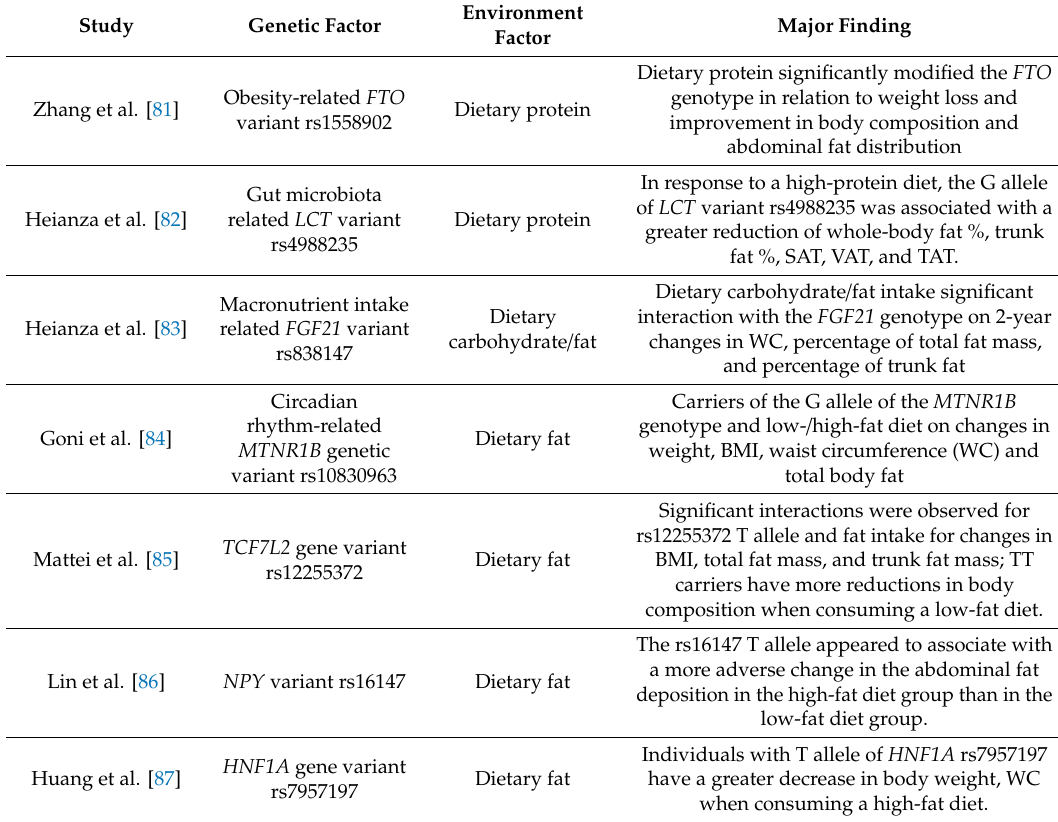
when consuming a high-fat